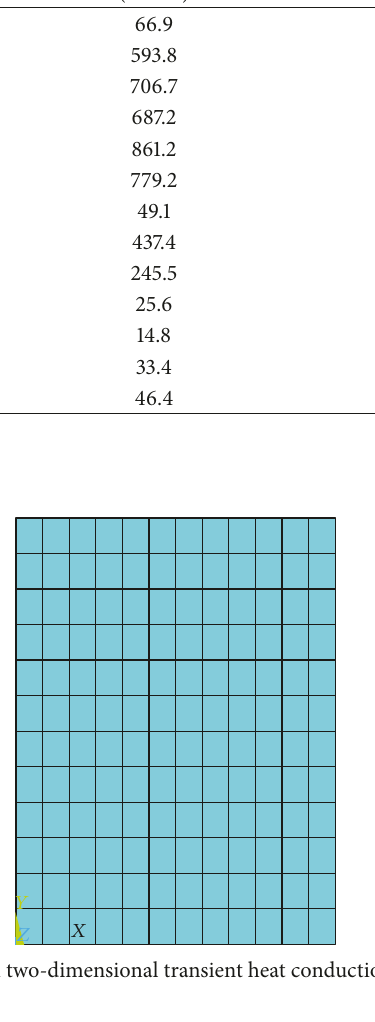
beam was completely exposed to the sun except for the cloudy at 2:00 pm; the sun is blocked by the buildings after 5:00 pm. The test results of solar intensity are listed in Table